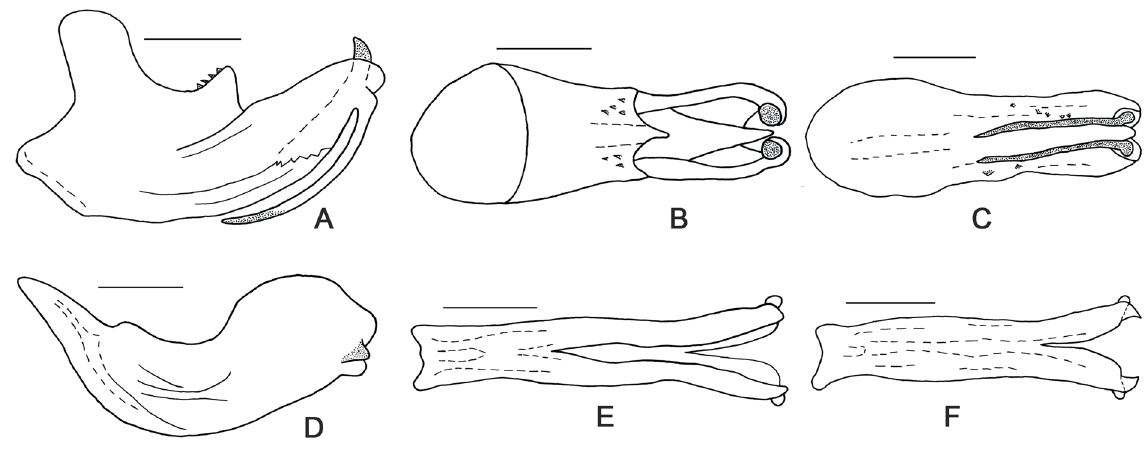
Fig. 7. Atracis punctulata sp. nov. A . Periandrium, right lateral view. B . Periandrium, dorsal view. C . Periandrium, ventral view. D . Aedeagus, right lateral view. E . Aedeagus, dorsal view. F . Aedeagus, ventral view. Scale bars = 0.5